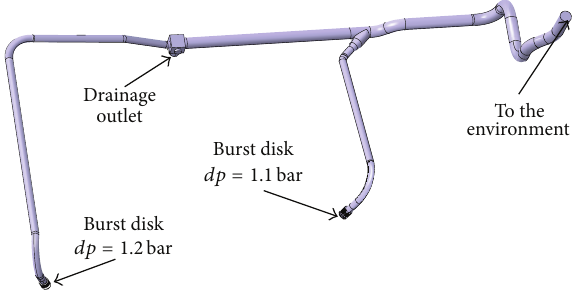
Figure 2: Layout of piping of W7-X plasma vessel venting